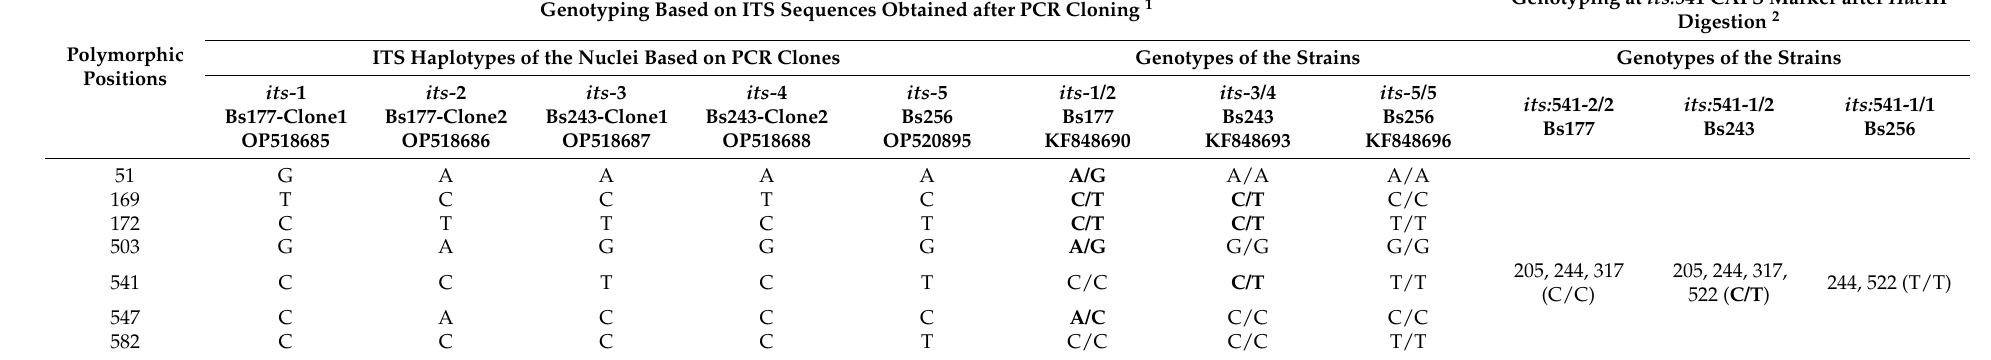
Table 1. Genotyping of three wild strains, either using ITS haplotypes or using the CAPS marker